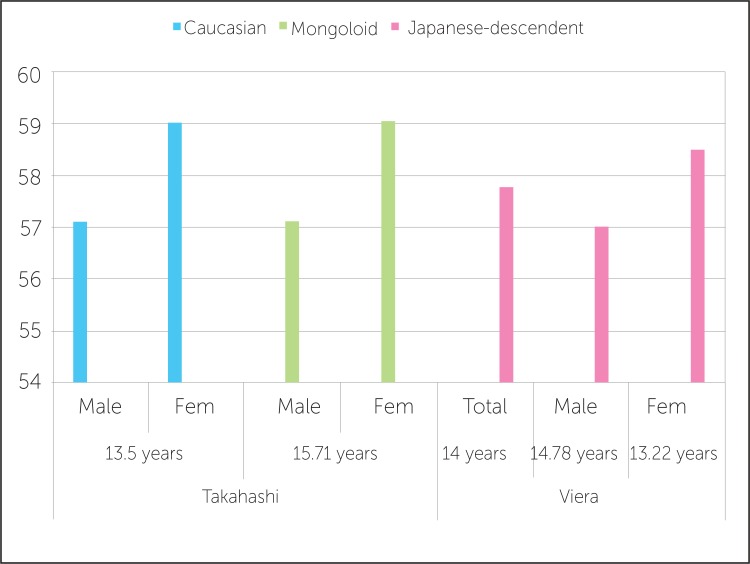
Means of LPFH - TPFH.